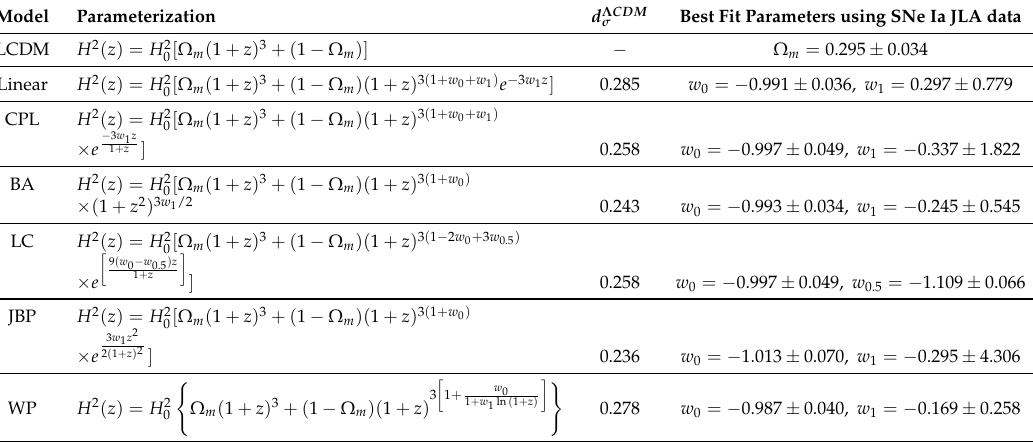
Table 1. Dark energy parameterizations with best fits and σ − distances values using SNe Ia JLA data.